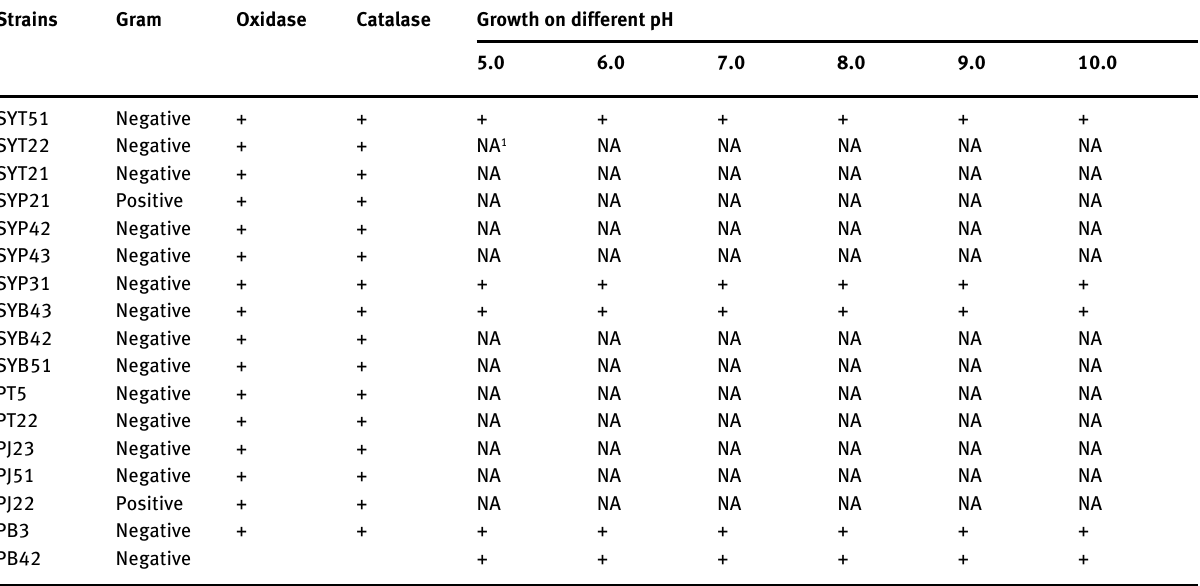
Table 3: Biochemical and physiological assays of bacterial strains isolated from the rhizosphere of soybean and peanut in North Sumatra